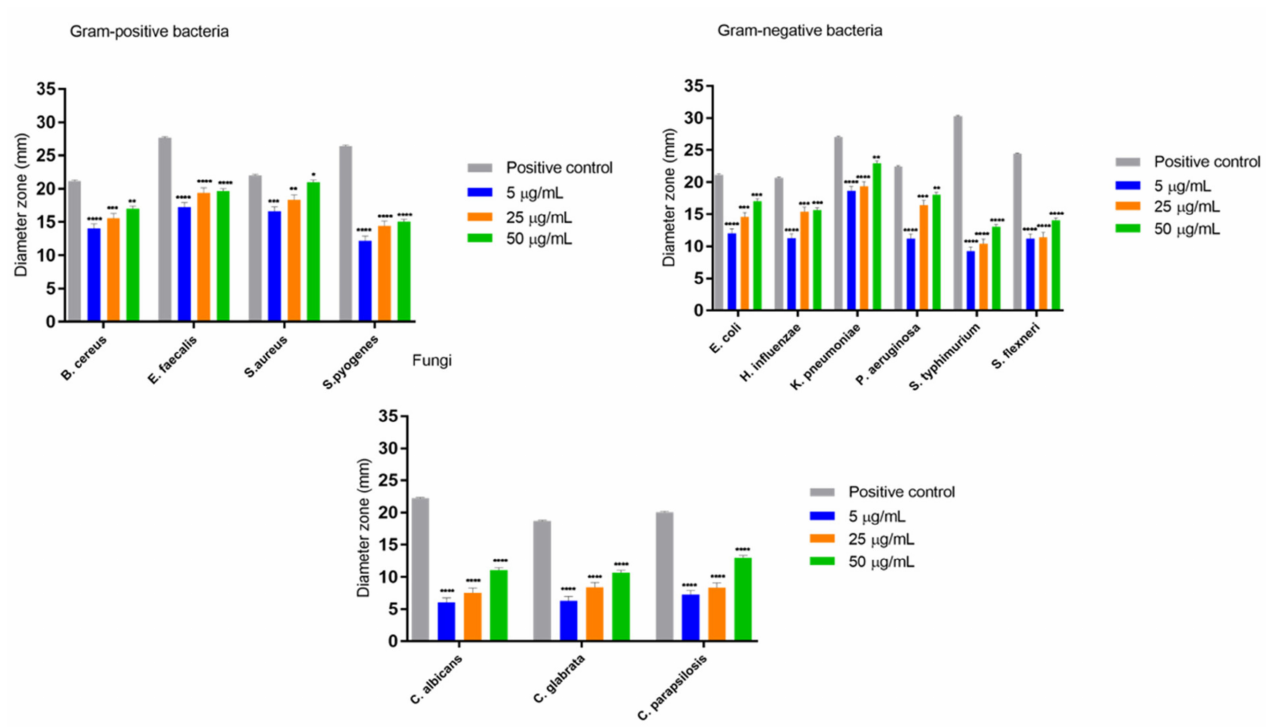
Figure 2. Antimicrobial activity of Melissa officinalis total extract (MOte) (5, 25, and 50 µ g/mL) in Gram-positive bacteria , Gram-negative bacteria and fungi assessed by disk diffusion method. The results are expressed as diameter zone of inhibition. The data represent the mean values ± SD of three independent experiments performed in triplicate. One-way ANOVA analysis was applied to determine the statistical differences in rapport with control cells followed by Tukey post-test (* p < 0.05, ** p < 0.01, *** p < 0.001, **** p <